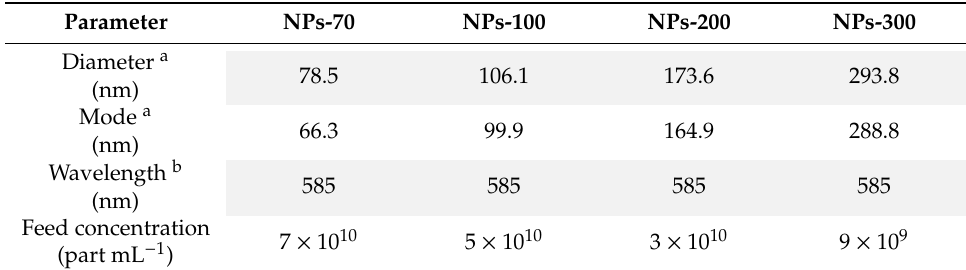
Table 1. Physicochemical characteristics of the nanoparticles (NPs) used in suspensions.